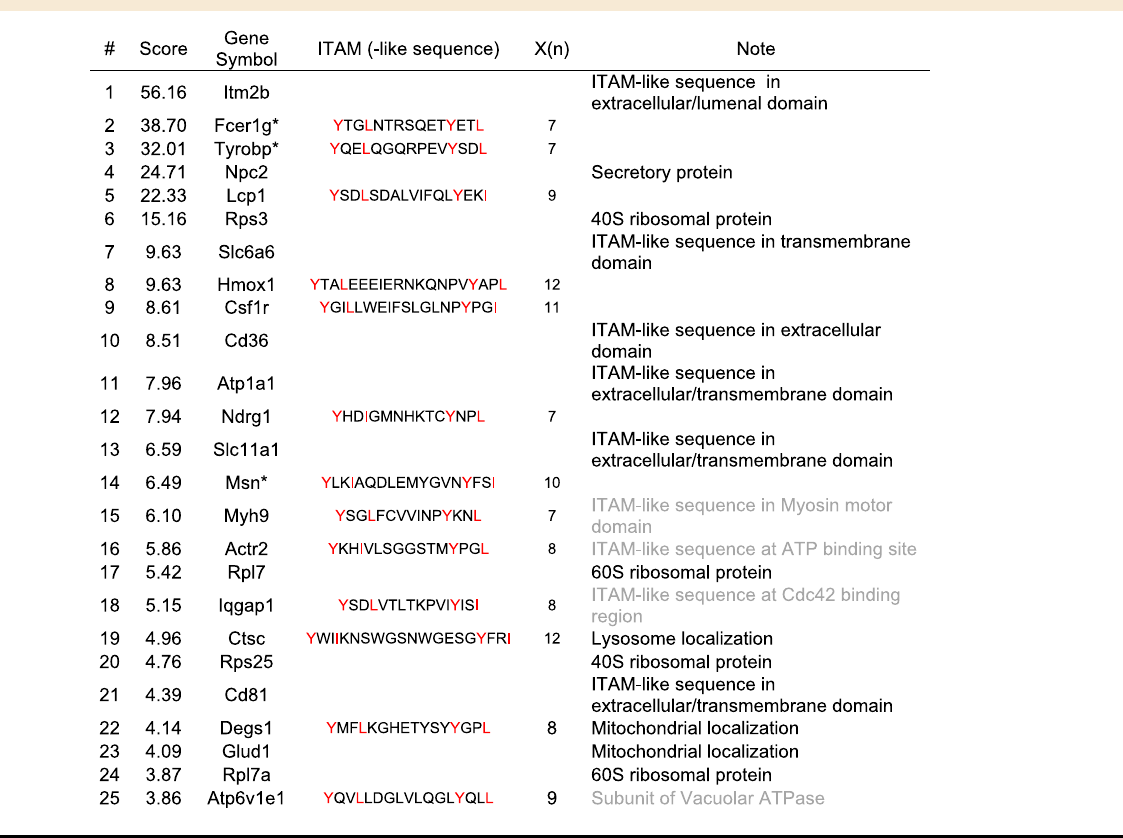
Table 1 Top 25 hits of highly expressed ITAM-like sequence-containing proteins in the mouse genome